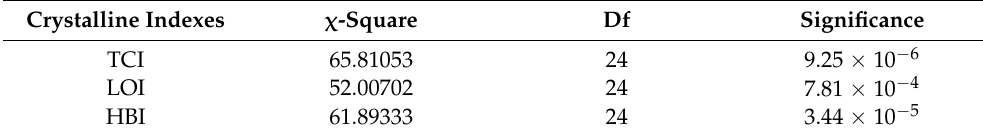
Table 3. Kruskal–Wallis analysis for the crystalline indexes and hydrogen bond index.